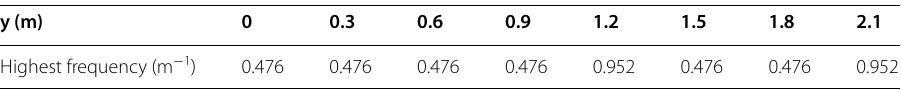
Table 5 Highest frequency of shape